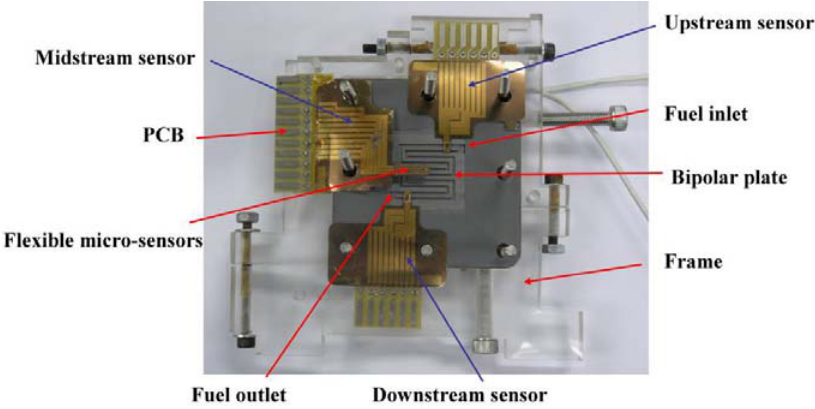
Figure 10. Proposed device embedded in PEM fuel cell.